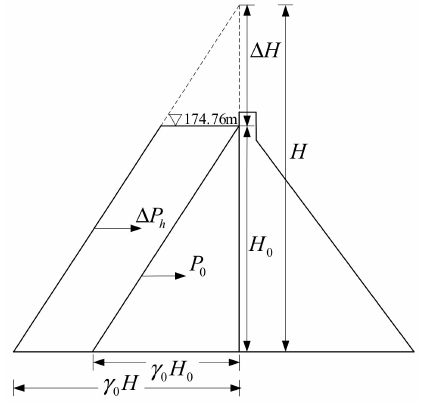
Figure 16. The excess water level